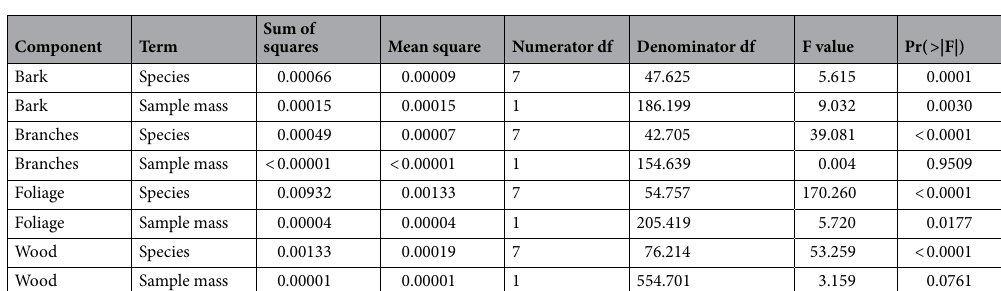
Table 2. Results of mixed effects ANCOVA explaining impacts of the species studied and sample masses on the differences in dry mass between two drying temperatures (D).